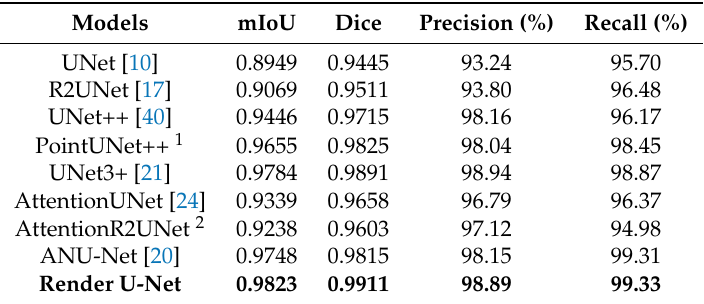
Table 2. The experiment results of the LiTS test dataset.